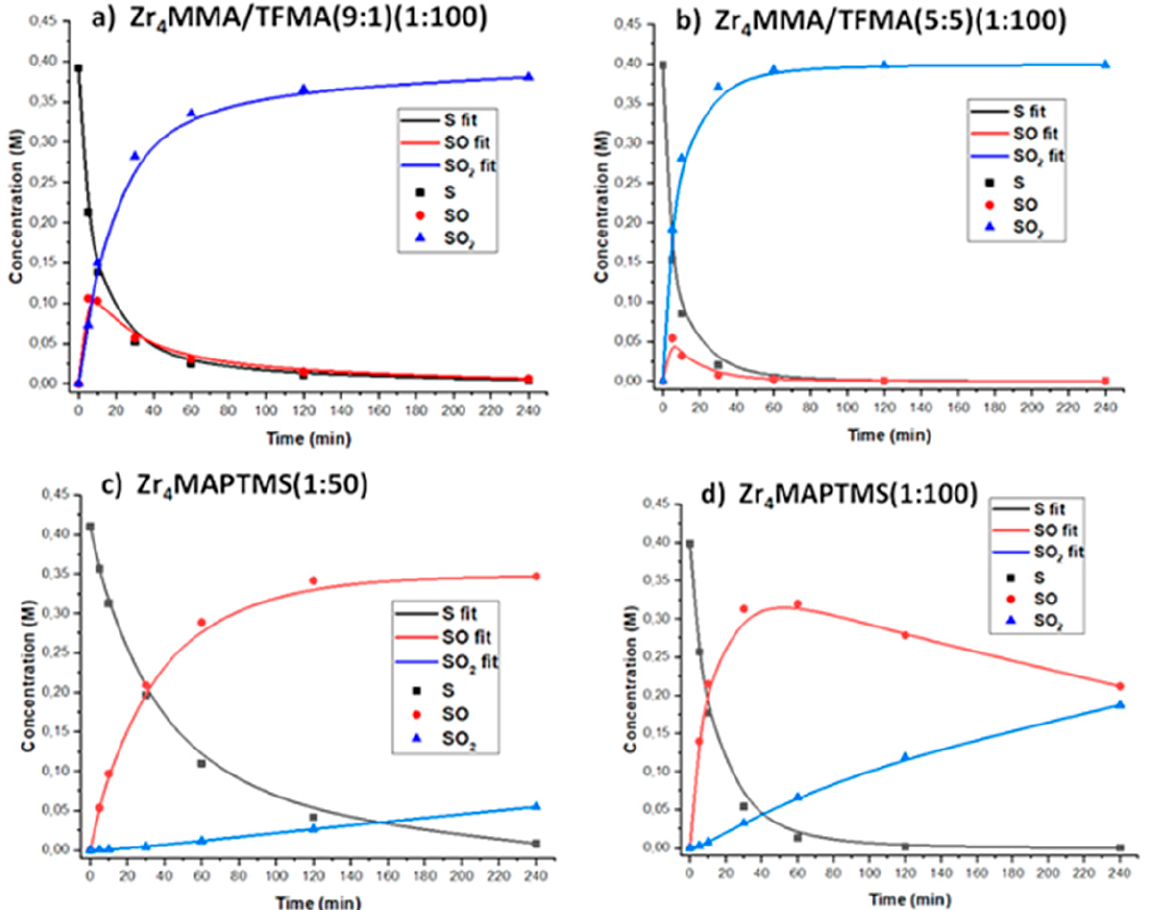
Figure 5. Catalytic performances, including second order kinetic fitting, of ( a ) Zr4MMA/TFMA(9:1) (1:100), ( b ) Zr4MMA/TFMA(5:5) (1:100), ( c ) Zr4MAPTMS(1:50), ( d ) Zr4MAPTMS(1:100). Conditions: 1 mmol sulphide, oxocluster 0.28–0.29 % mol, 2 mmol of H 2 O 2 in 2.2 mL of ACN, T = 50 ◦ C. The kinetic behaviour is, in all cases, well described by second order kinetics, with reaction rates − d[S]/dt = k[S] and d[SO 2 ]/dt = k 2 [SO], where k 1 and k 2 are the values for the first and second reaction steps. In Table 5, kinetic constants and the selectivity parameter, reported as the ratio between the kinetic constants ( S = k 1 /k 2 ) are